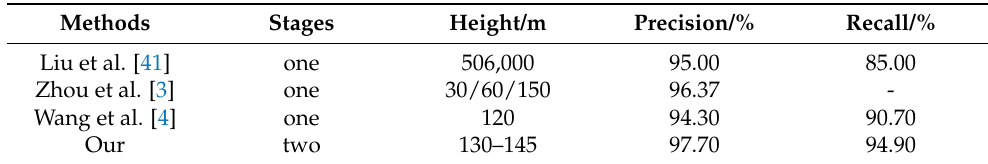
Table 11. The comparison between our work and that of other